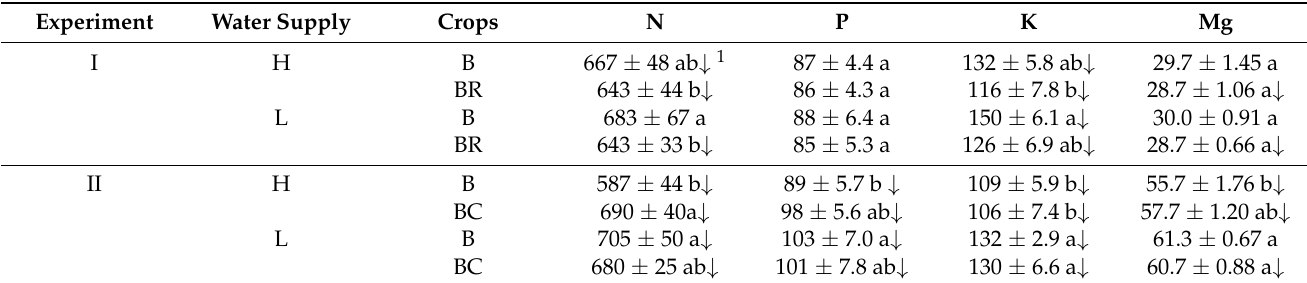
Table 4. Nutrient content in soil, mg kg –1 DM (average ± standard error). Experiment